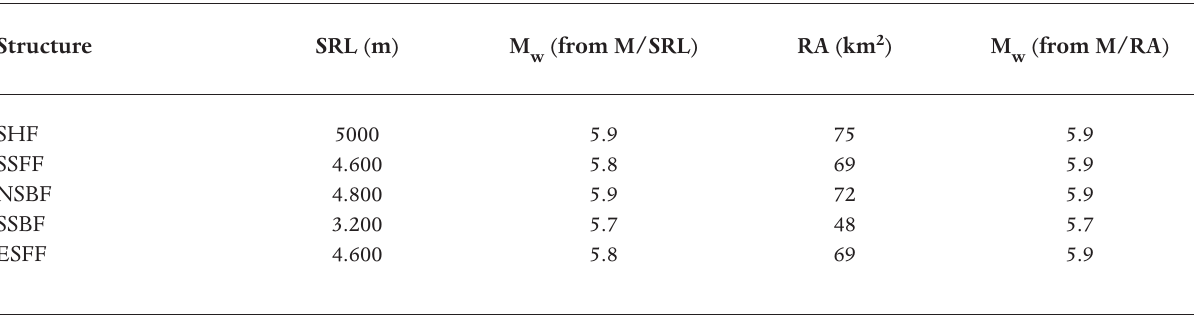
Table 5. Maximum expected magnitudes from surface rupture length (SRL) and rupture area (RA) for Graciosa faults. M/SRL